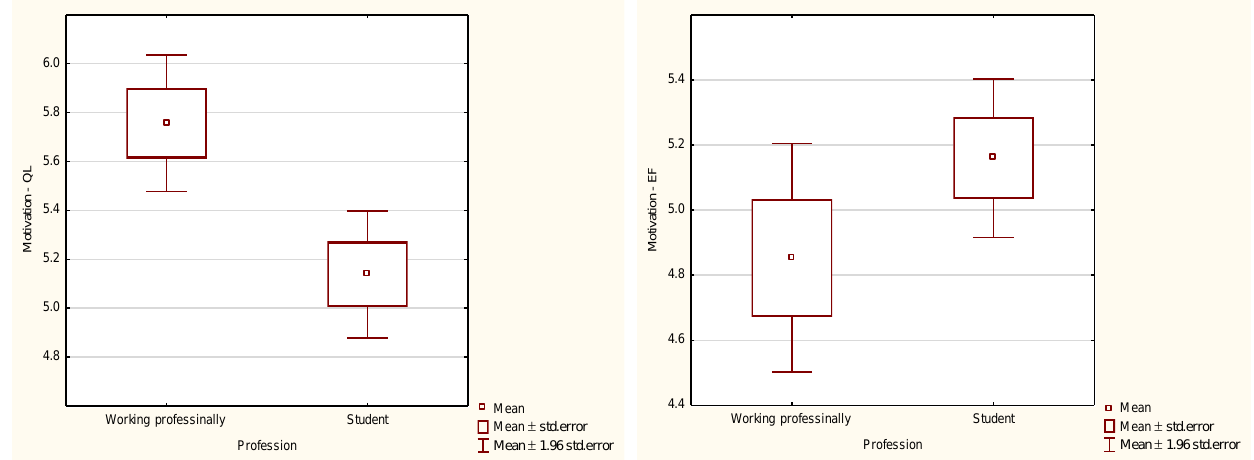
Figure 16. The quality of life and economic factors influencing the transport choice in various industry groups.